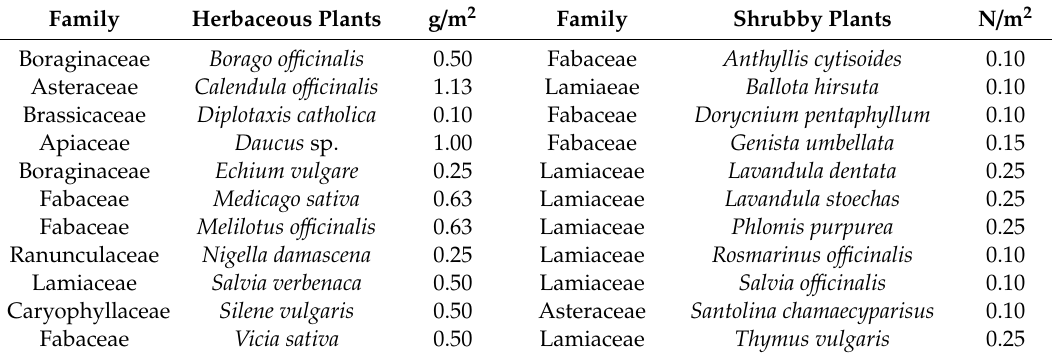
Table 1. Plant species used in the herbaceous and shrubby plant mixtures. Grams of seeds per